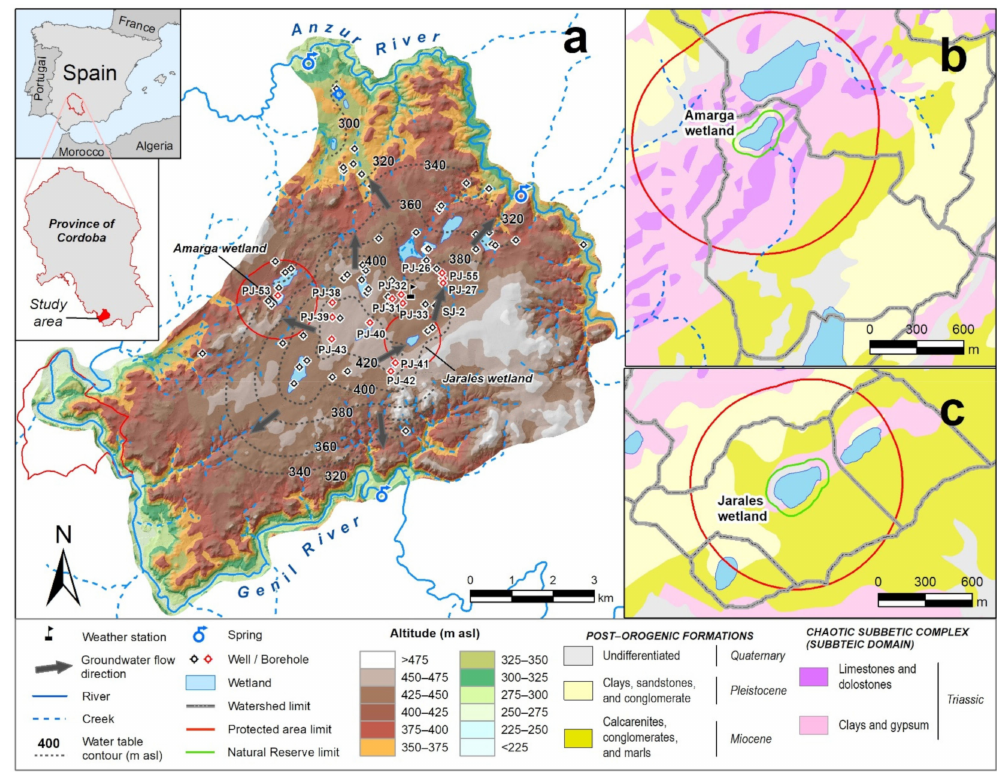
Figure 1. ( a ) Location and general settings of the study area, including groundwater table contours. Geology of the wetland watersheds, after Mart í n-Serrano [33]: ( b ) Amarga and ( c )